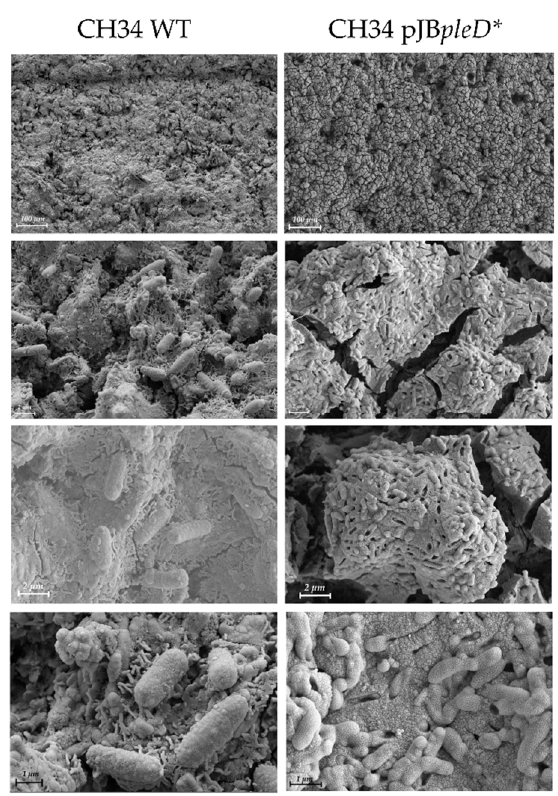
Figure 4. Scanning electron micrographs of the biofilms of C. metallidurans strains CH34 and CH34 pJB pleD * on electrode surfaces after 15 days. Different scales of viewing are shown. CH34 pJB pleD * biofilms showed diminished cell sizes, changes in cell surface, and the increased presence of EPSs in the extracellular matrix.